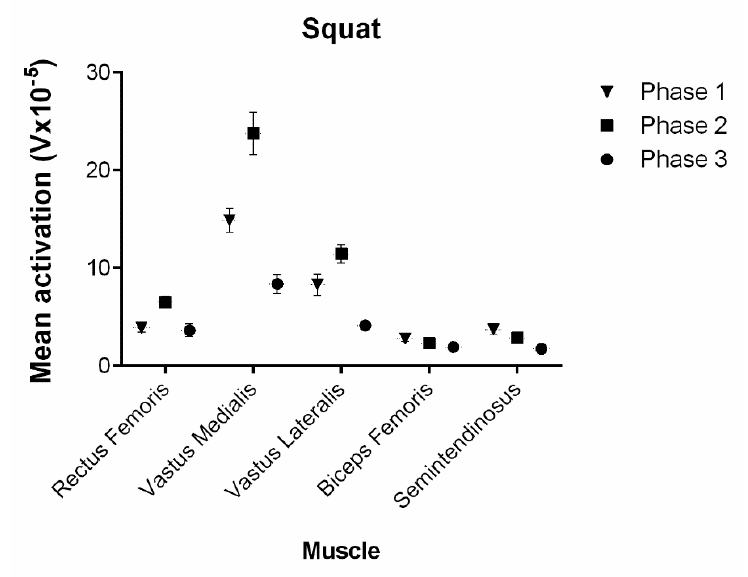
Figure 7. Mean activation (V × 10 − 5 ) of all the muscles in each phase in squat. The first phase corresponds to the descent, the second to the isometric phase and the third to the ascent. The vertical lines around the data represent the SD.